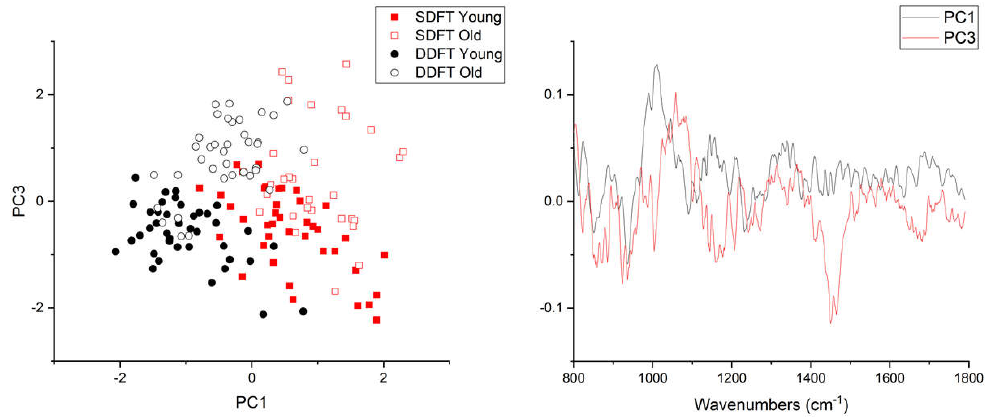
Figure 5. Principal component analysis of pooled Raman spectra. Left , scatter plot of PC1 and PC3 axis. PC1 separates tendon types and PC3 separates age groups. Right , PC1 and PC3 vector loadings.